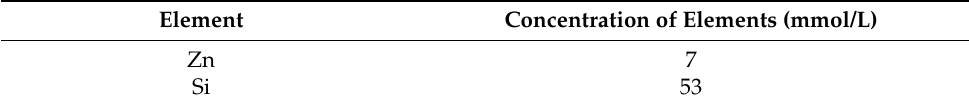
Table 7. Elemental concentrations of aqueous pore solution for MFS slag R 3 paste.